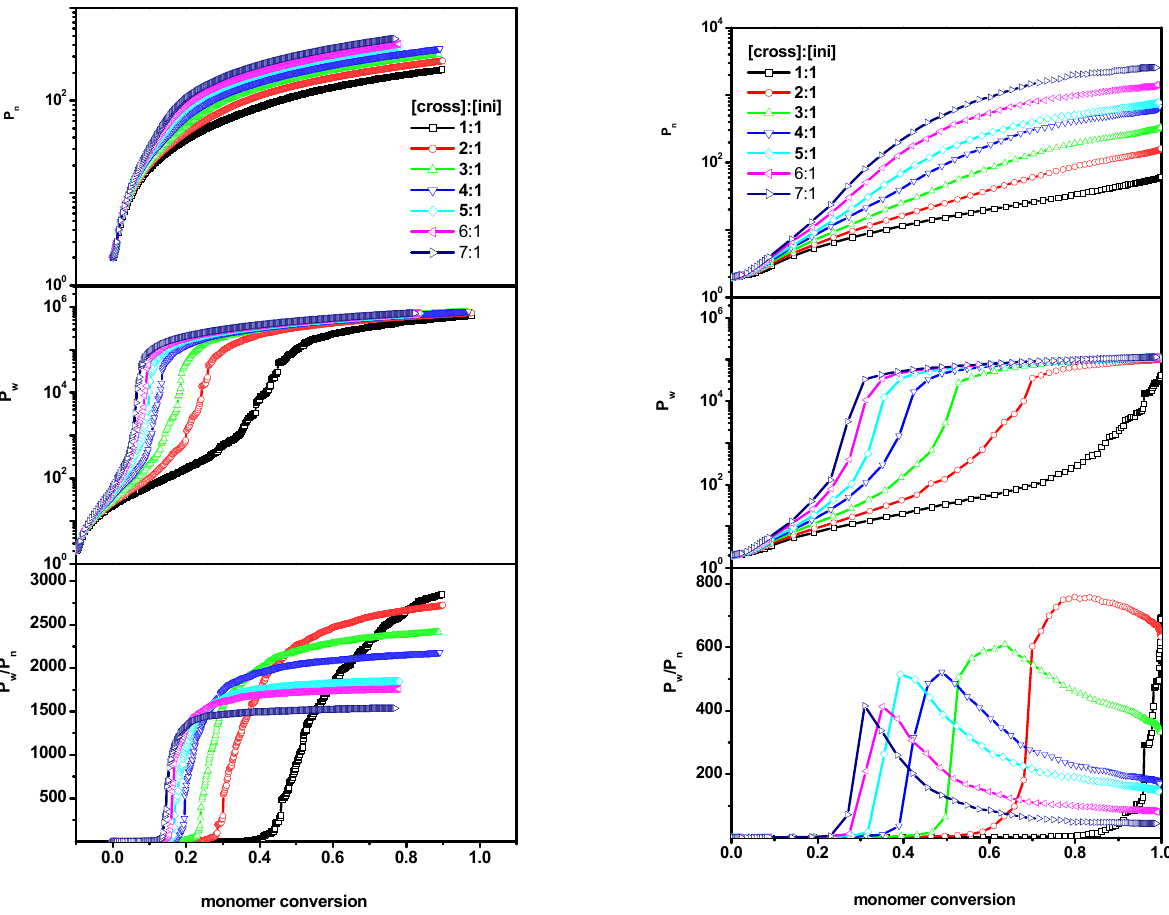
Figure 3. The number-average chain length ( P n ) ( upper ), the weight-average ( P w ) ( middle ) and the dispersity ( P w / P n ) ( lower ) vs. monomer conversion for the initiator concentration 0.6% (it corresponds to the grafting density σ = 0.6) in the slit with chains grafted to one of the walls (system C). The case of the distance between walls d = 100 ( left panel) and d = 10 ( right panel). The values of the ratios [Ini]/[X] are given in the insets to the upper